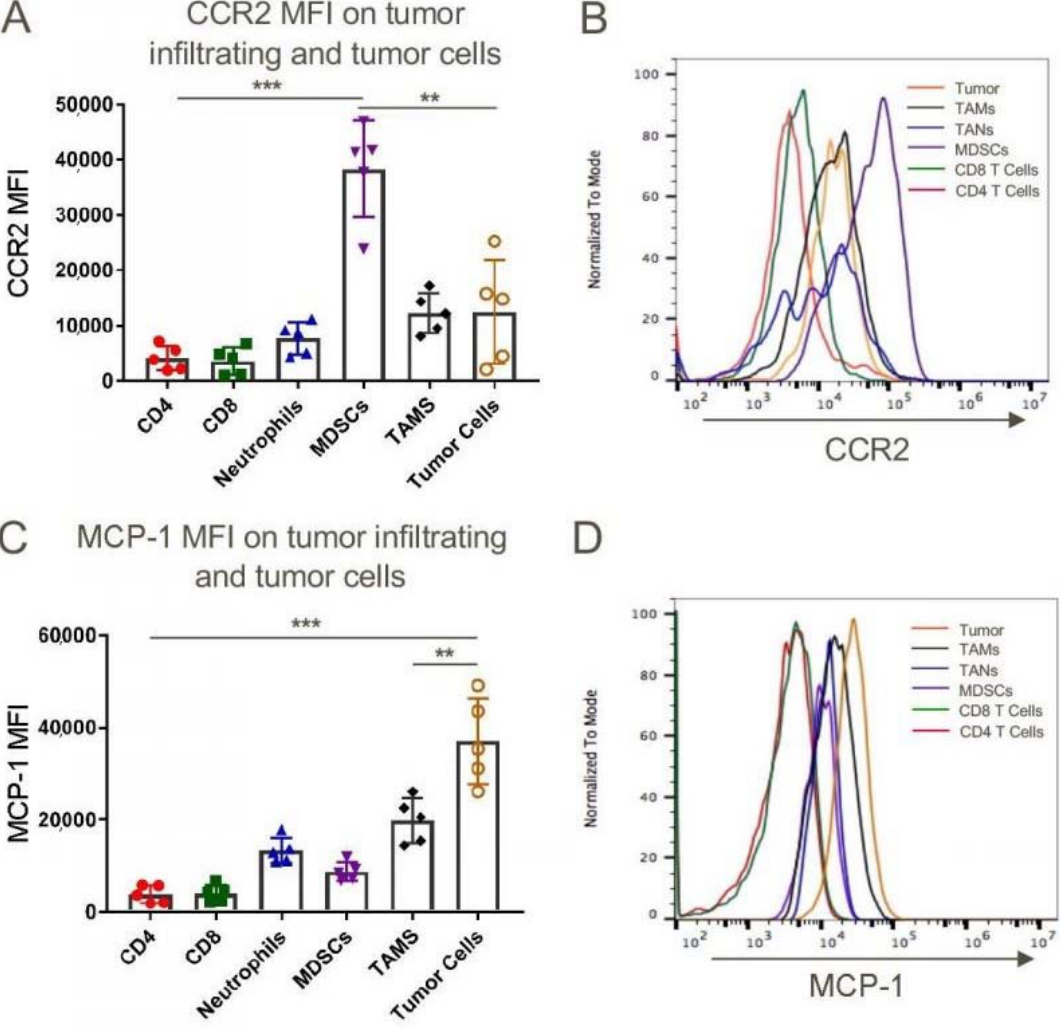
Figure 1. Myeloid ‐ derived suppressor cells (MDSCs) derived from subcutaneously transplanted mouse lung epithelial cell tumor TC1 expressed the highest levels of chemokine CCR2 whereas tumor cells are the major source of CCL2 (MCP ‐ 1). WT C57BL/6 mice were injected subcutaneously with 1 million TC1 cells and tumors were harvested 21 days post ‐ injection and were analyzed for CCR2 ( A , B ) and CCL2 ( C , D ) expression by flow cytometry; ** p < 0.01 and *** p < 0.001, n = 5/group. Data are representative of three independent experiments.